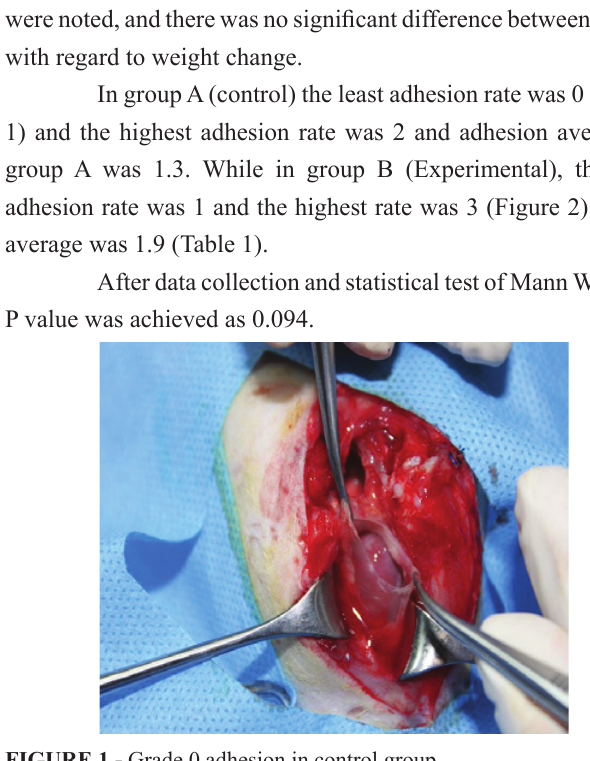
FIGURE 1 - Grade 0 adhesion in control